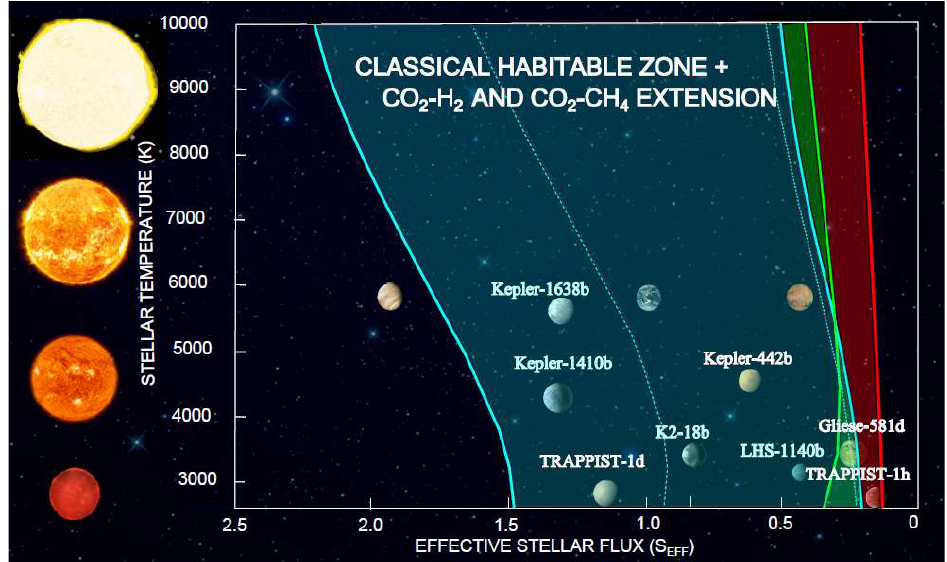
Figure 8. The classical HZ (blue) with CO 2 –CH 4 (green) and CO 2 –H 2 (red) extensions for stars of stellar temperatures between 2600 and 10,000 K (A–M-stars). The same classical HZ boundaries shown in Figures 3 and 5 are also shown. Some solar system planets and exoplanets are also shown. Based on work from Ramirez and Kaltenegger [2,131,132] and Ramirez [22].